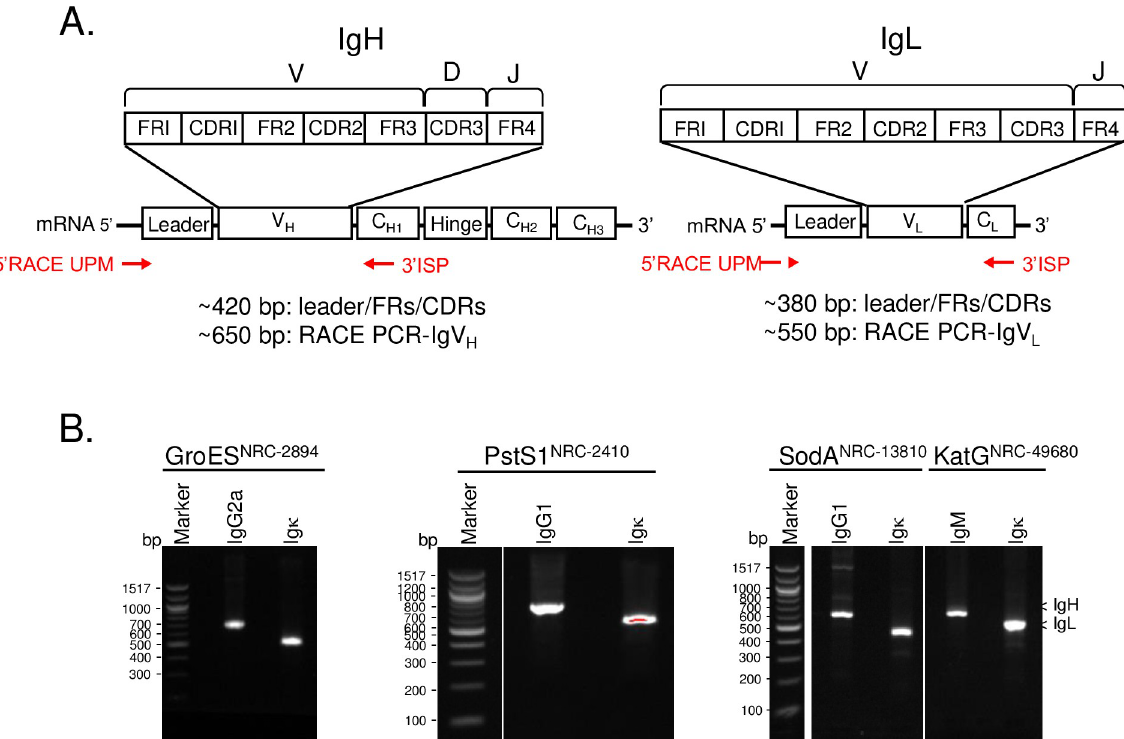
Fig 1. 5’ RACE-PCR immunoglobulin heavy (IgV H ) and light (IgV L ) chain products for each of the 4 hybridoma cell lines. A. Illustration of the 5’ RACE-PCR amplicons of IgV H and IgV L used in this study. The 5’ RACE Universal Primer (5’ RACE UPM) and antisense, 3’ isotype- specific primer (3’ ISP) were marked. B . Agarose gel electrophoresis of the 5’ RACE-PCR amplicons of IgV H and IgV L for the 4 hybridoma cell lines. The amplicons were separated by 1.5% low melting agarose electrophoresis with ethidium bromide and were excised, extracted, and column purified. The corresponding amplicons of IgV H or IgV L were used either for generating an NGS library for MiSeq Illumina sequencing or for cloning into a TOPO-TA vector, followed by Sanger